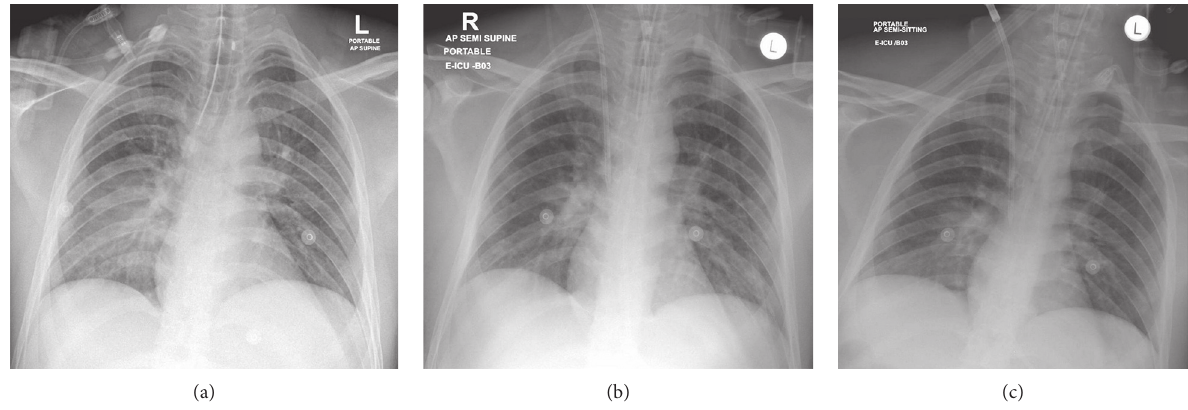
Figure 2: Repeat chest X-rays also did not show any classical findings for